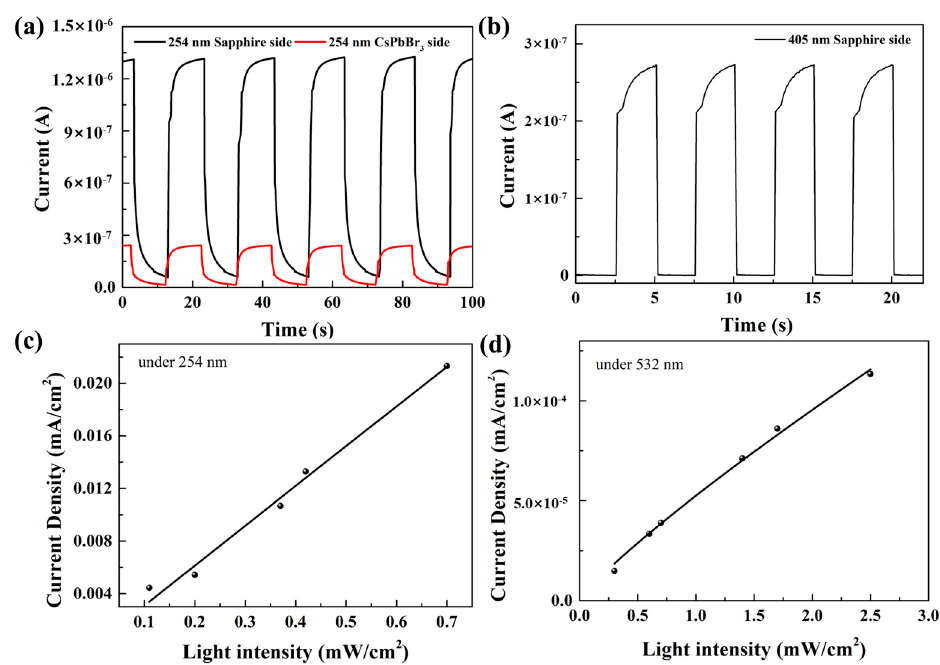
Figure 4. Time-dependent photo response characteristics of the Ga 2 O 3 /CsPbBr 3 heterojunction PD under 254 nm ( a ) and 405 nm ( b ) lights. The light–current density values versus light–intensity plots, along with the fitting results using the power law of J − P α , for the PD under 254 nm ( c ) and 532 nm ( d ) lights.